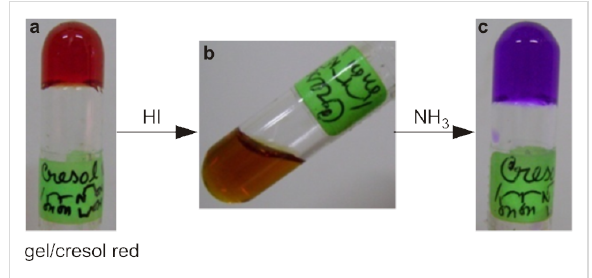
Figure 3: Acid-instability and base-stability of the hydrogel of 2 in 1:1 DMSO/water.